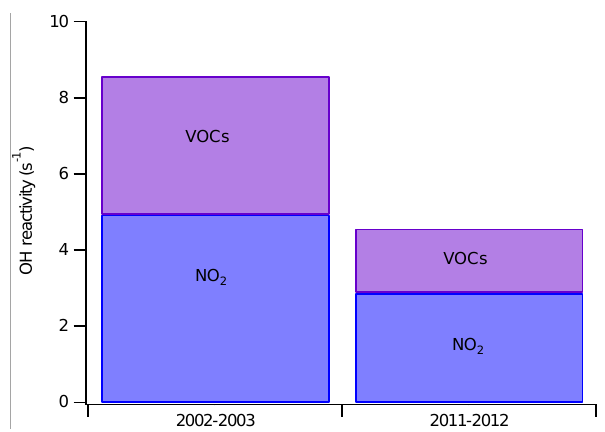
Figure 7. OH reactivity (s − 1 ) to NO 2 and NAPS VOCs in the “early” period (2002–2003) and “late” period (2011–2012) at the Downtown sites.